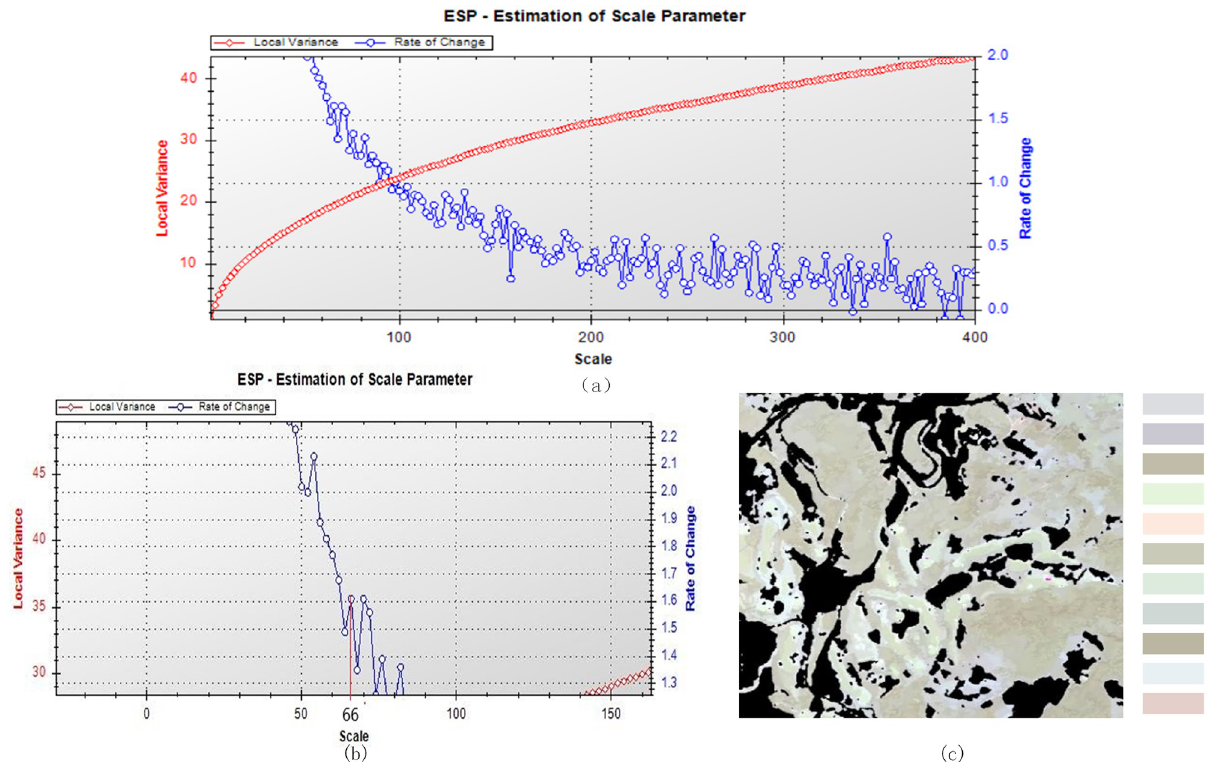
Fig 5. Multiresolution segmentation (SS = 66, WS_1 = 0.5, WC = 0.7): (a) variance curve, (b) optimal segmentation scale and (c) image object.